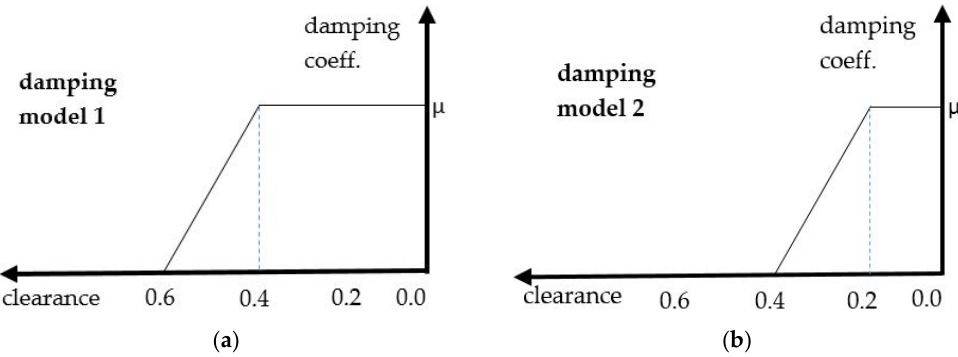
Figure 14. Contact damping models: ( a ) 0.6 mm total clearance; ( b ) 0.4 mm total clearance. Table 4. Damped contact simulation set-up.